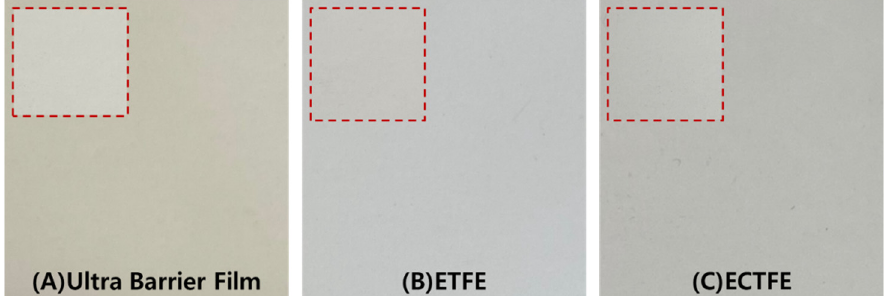
Figure 1. Front material after UV test (size: 4 cm 2 ) ( A ) Ultra-barrier film ( B ) ETFE and ( C ) ECTFE (dotted line is the sample before UV test).